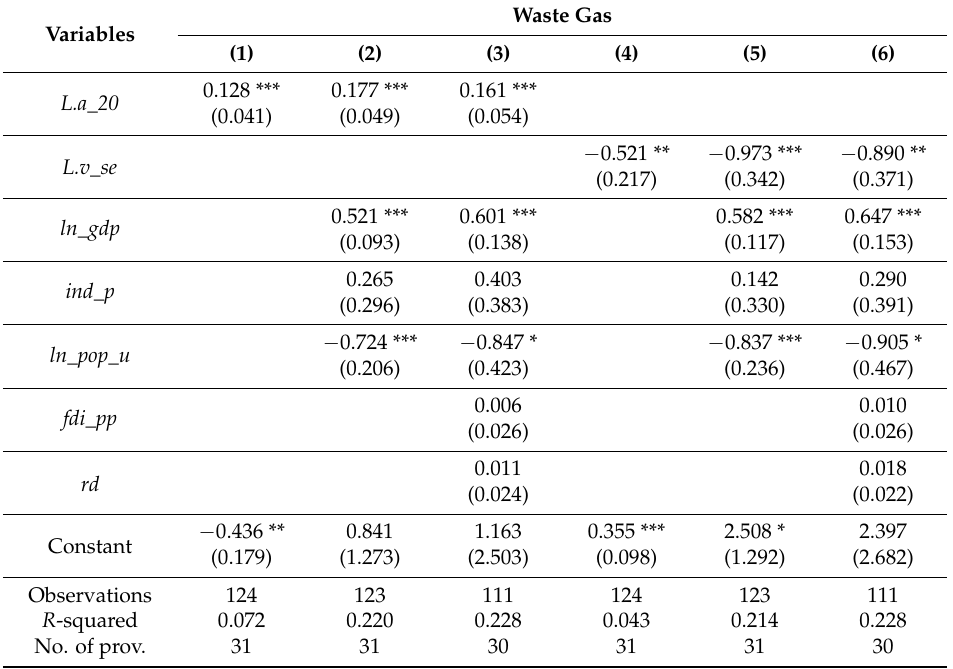
Table 6. Robustness check on the waste gas governance response vis- à -vis public environmental